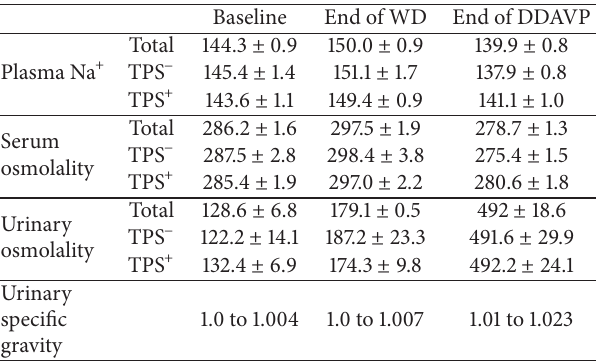
Table 2: Plasma and urine